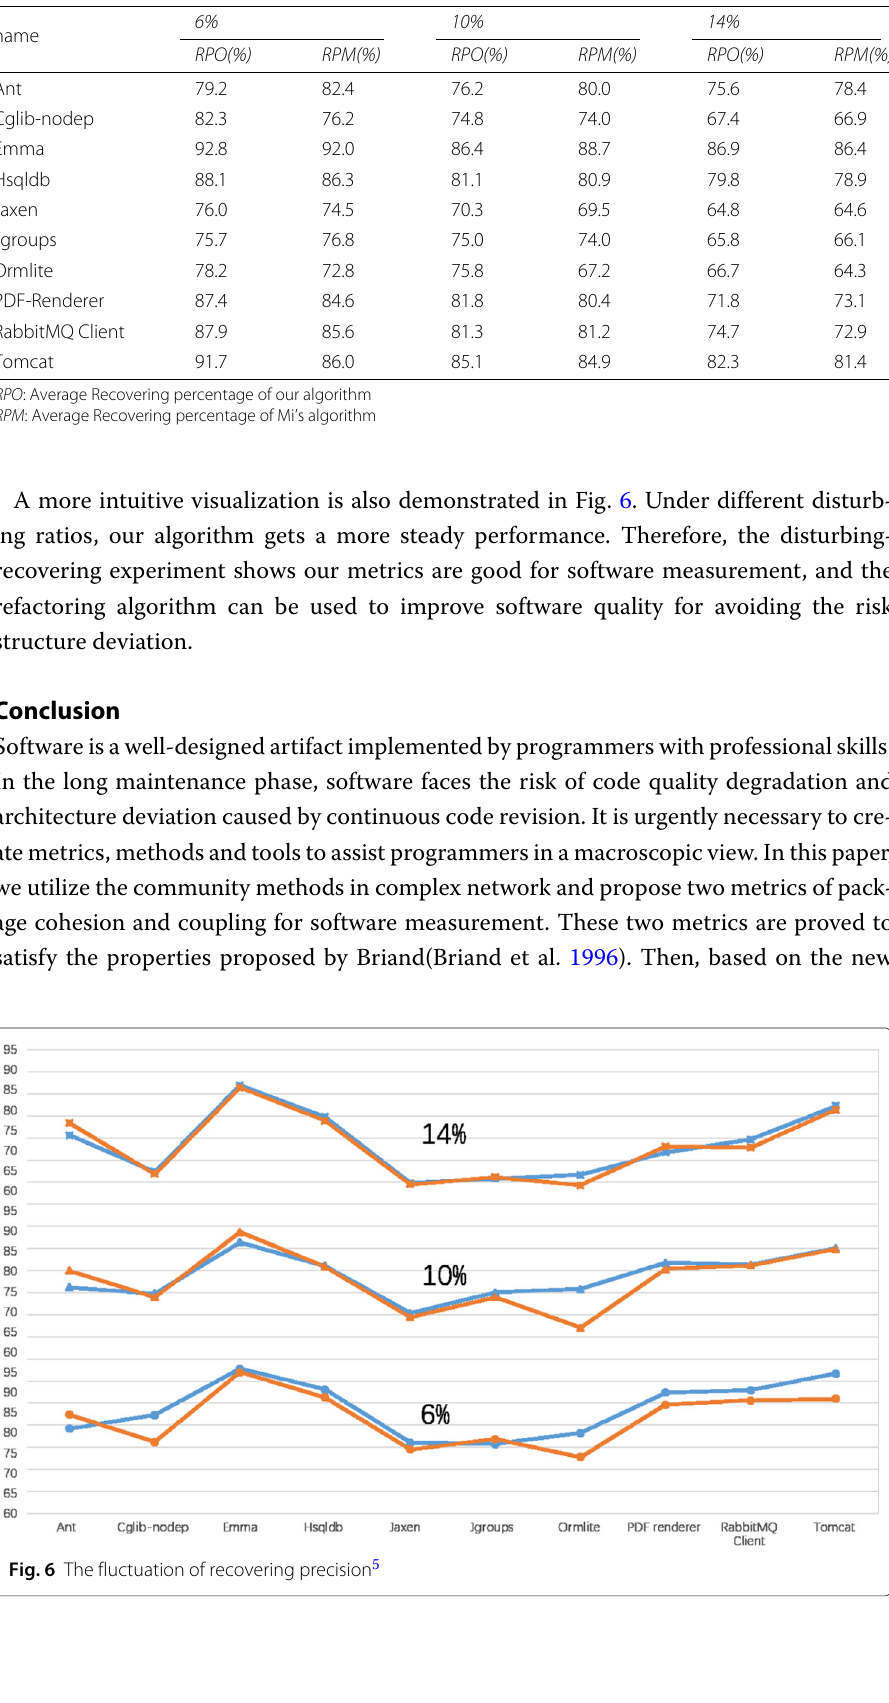
Table 5 Disturbing-recovering comparison under different disturbing